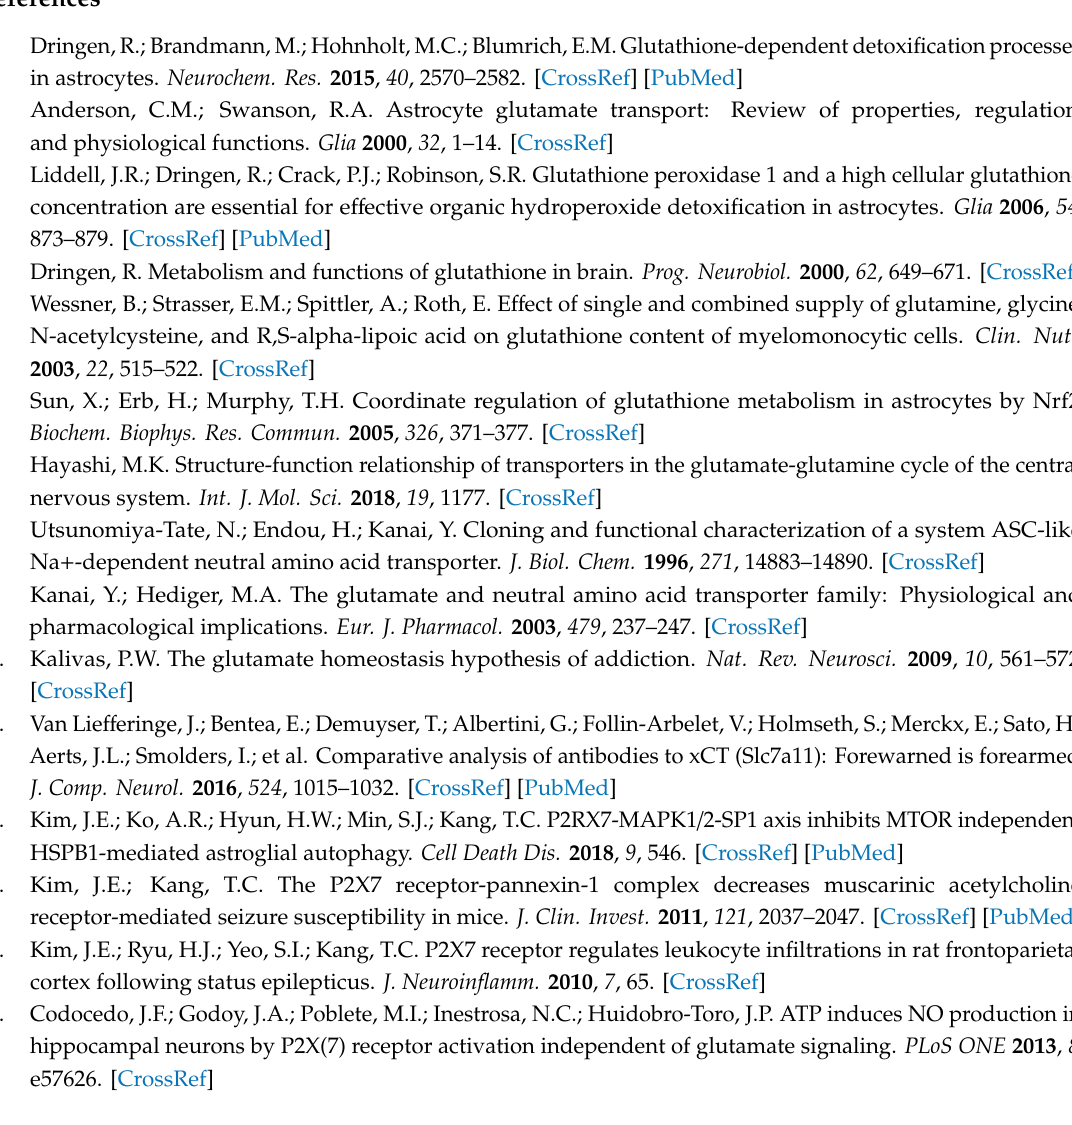
Figure S1: Full-length gel images of western blot data in Figure 1A, Figure S2: Full-length gel images of western blot data in Figure 3A, Figure S3: Full-length gel images of western blot data in Figure